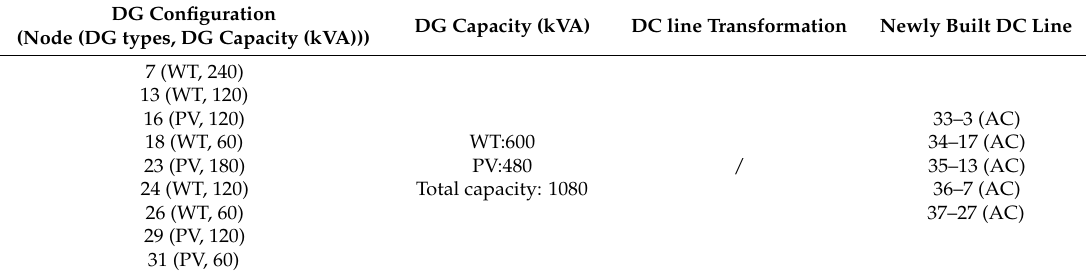
Table 5. The planning results without considering DC line transformation and newly built DC